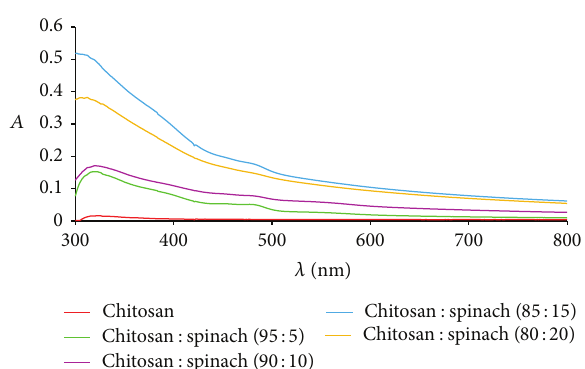
Figure 1: UV-Vis spectra of chitosan and chitosan-spinach blend films.